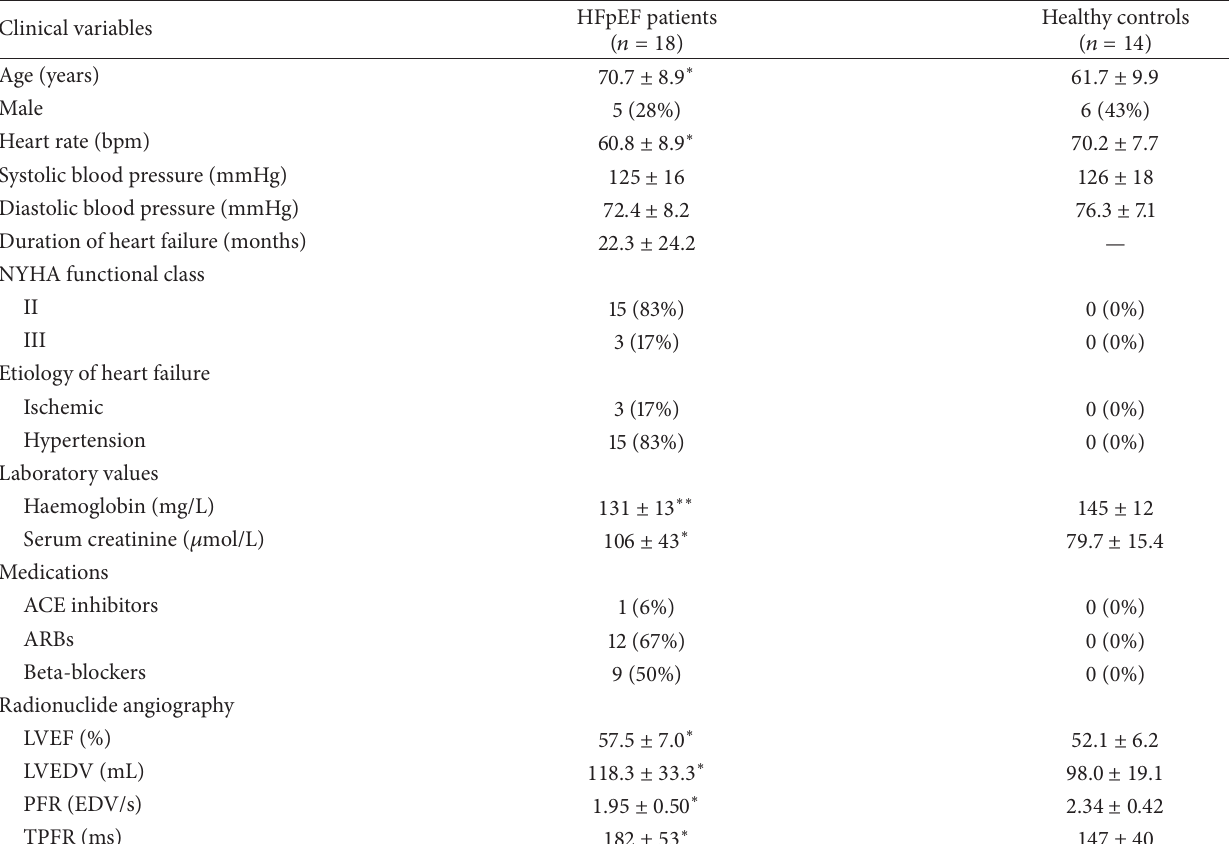
Table 1: Baseline characteristics of the study